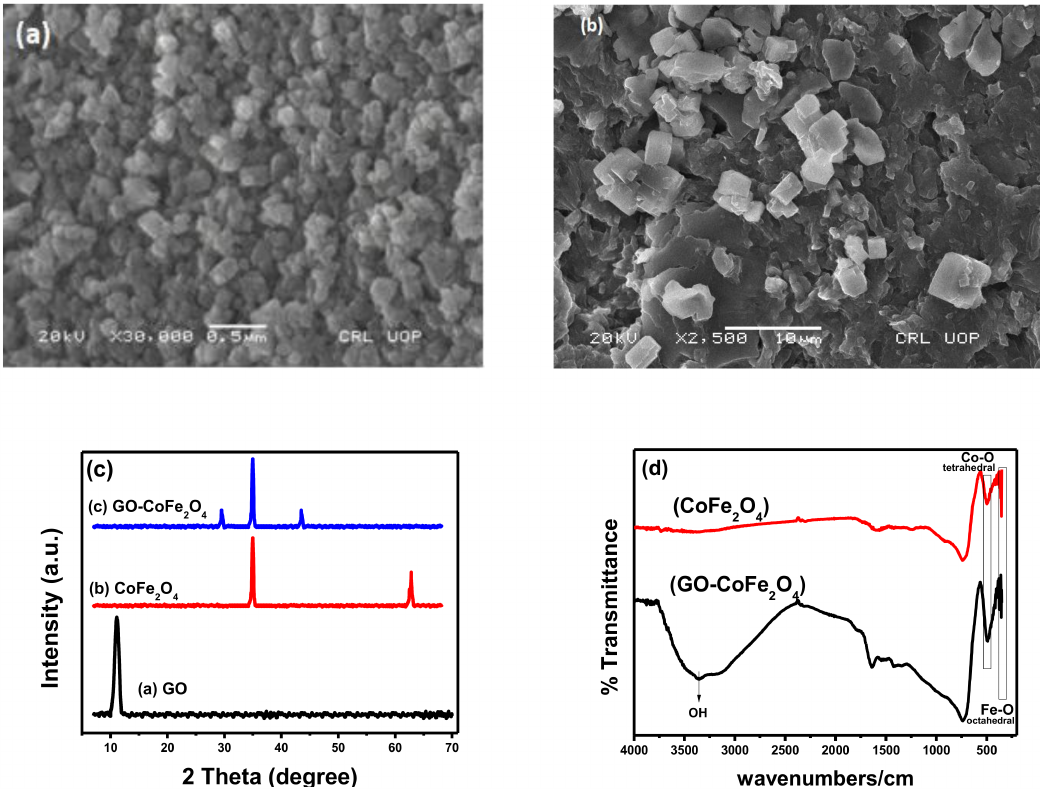
Figure 1. Characterization analysis of catalysts; SEM images of ( a ) CoFe 2 O 4 , ( b ) GO-CoFe 2 O 4 , ( c ) XRD patterns, and ( d ) FTIR spectra CoFe 2 O 4 alone and its GO-based